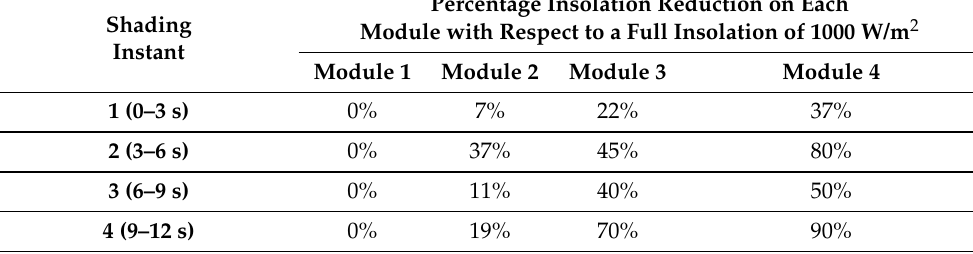
Table 3. Percentage insolation reduction taking as a reference the full insolation on the four PV modules for every timeslot of the “randomly-varying insolation” dynamic PS scenario.